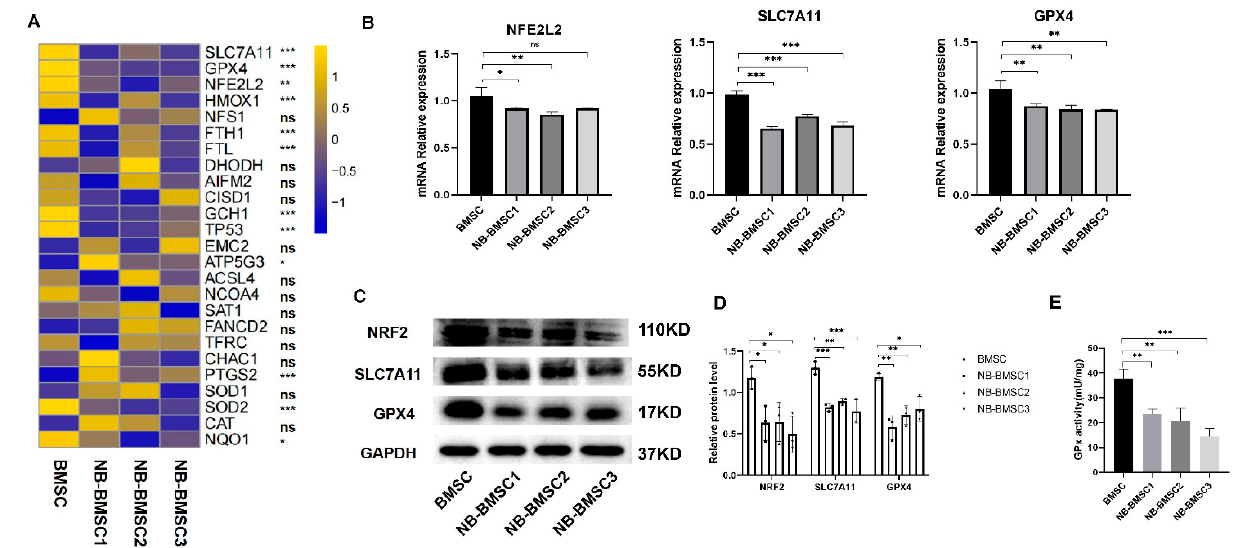
Figure 3. RNA-seq was performed and anti-ferroptosis pathways were selected. ( A , B ) The pathways linked with ferroptosis were selected. ( C , D ) Western blotting was used to analyze protein levels of NRF2, SLC7A11 and GPX4. ( E ) GPx activity was detected in BMSCs and NB-BMSCs. A one-way analysis of variance was used. ns not significant; * p < 0.05; ** p < 0.01; *** p < 0.001.